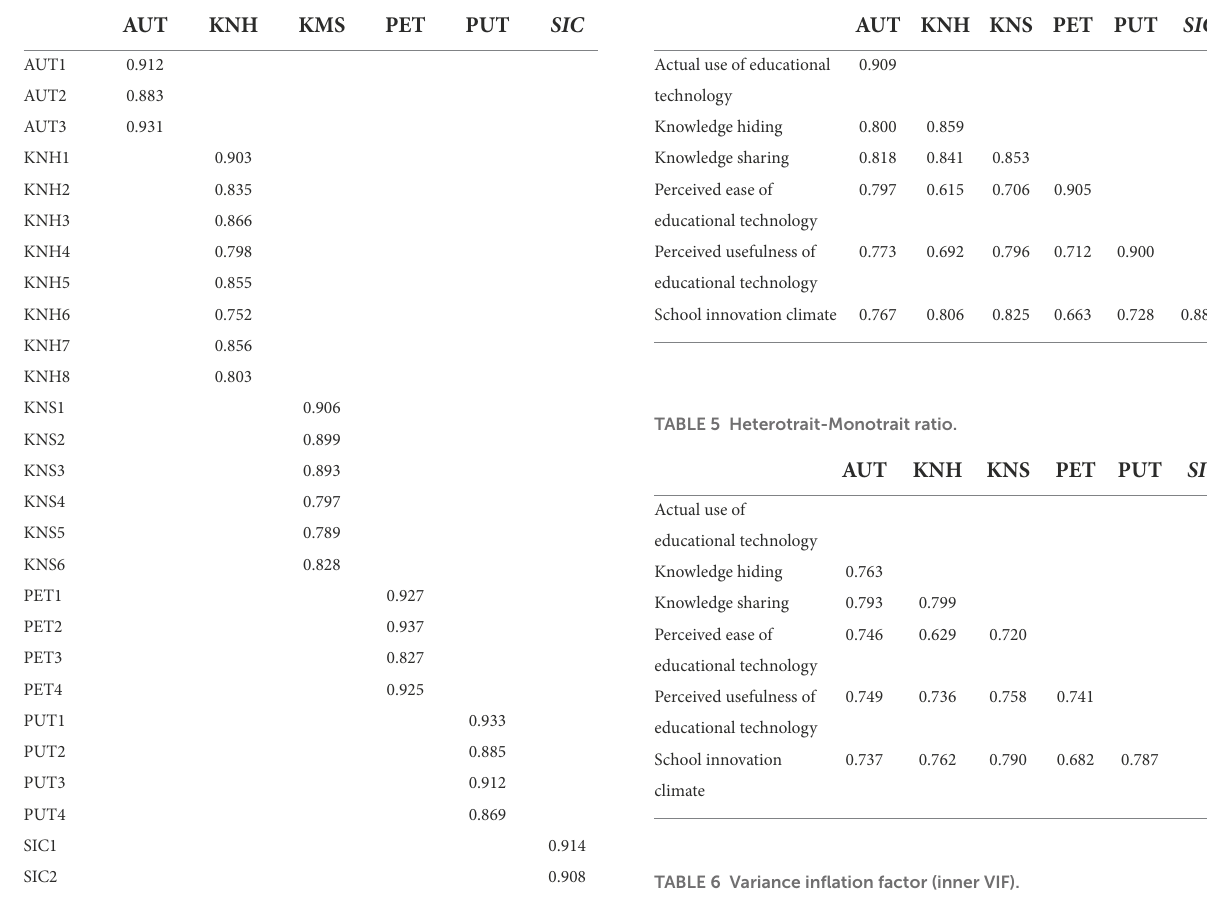
TABLE 6 Variance inflation factor (inner VIF).